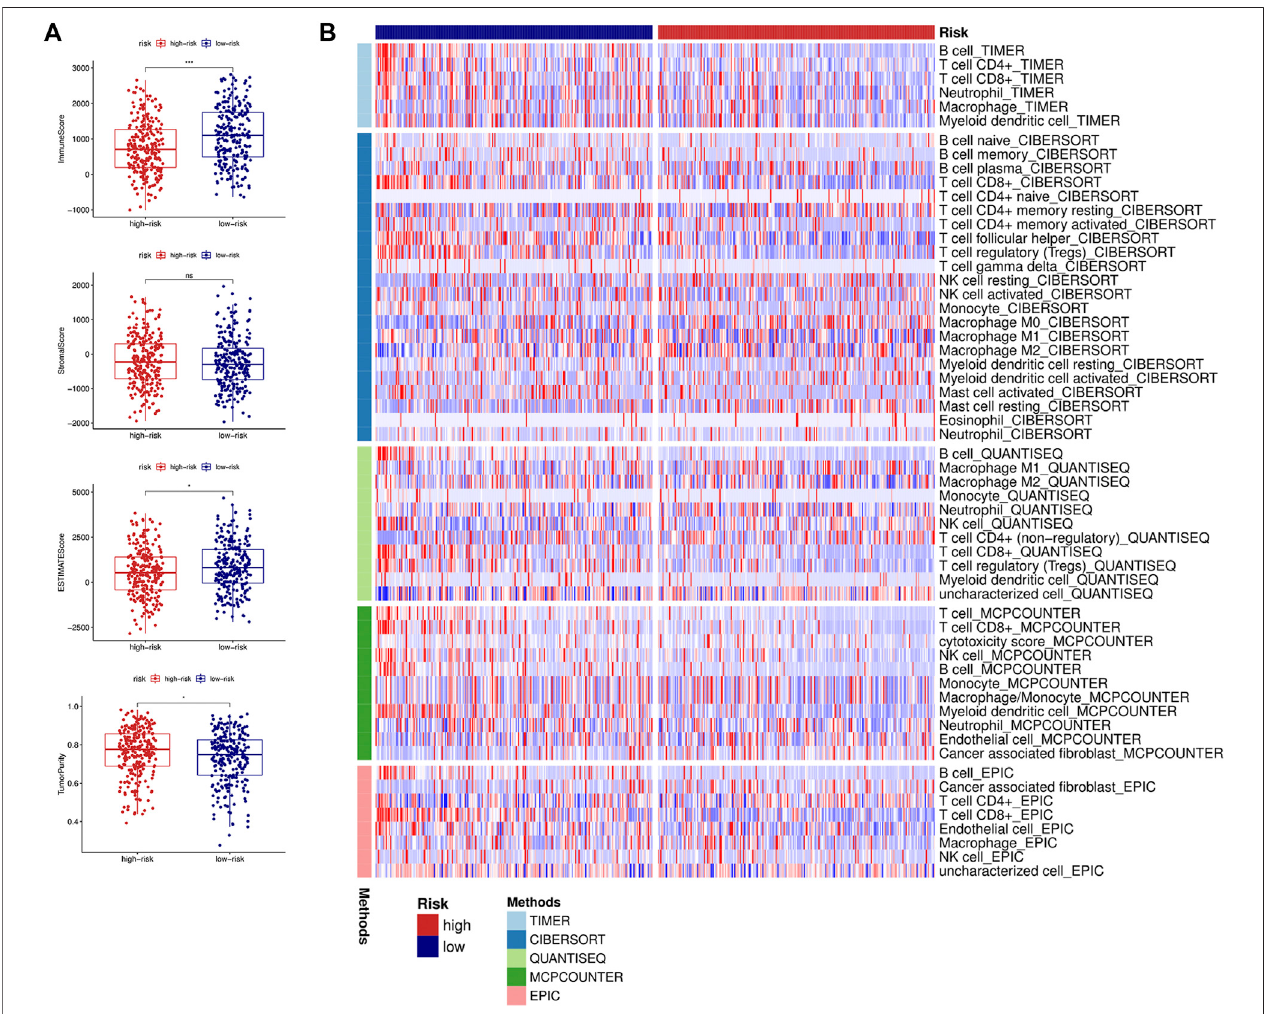
FIGURE 6 | Immune landscape between the high- and low-risk groups based on multiple algorithms. (A) Comparison of the immune score, stromal score, ESTIMATE score, and tumor purity between the high- and low-risk groups based on the ESTIMATE algorithm. (B) Heatmap of the immune cell in fi ltration calculated by fi ve algorithms, including TIMER, CIBERSORT, QUANTISEQ, MCPCOUNTER, and EPIC between the two groups. (C) Boxplot of the immune cell in fi ltration calculated by the abovementioned algorithms between the two groups. (* p < 0.05; ** p < 0.01; *** p < 0.001; ns, not signi fi cant).